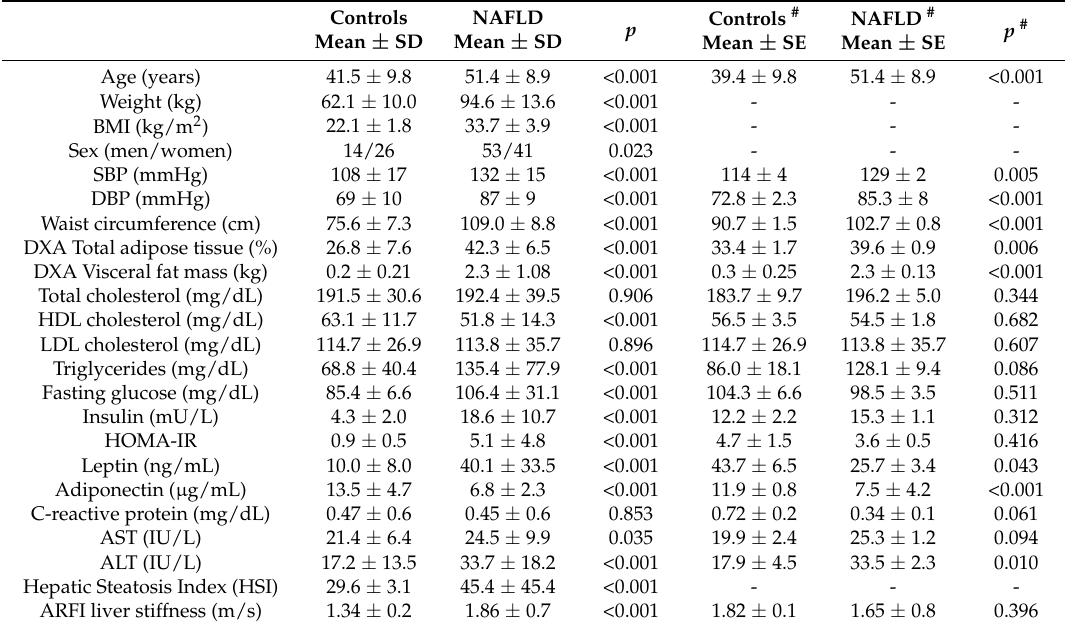
Table 1. Anthropometry, clinical features, and biochemical parameters of participants with ultrasound diagnosed NAFLD ( n = 94) and controls ( n =